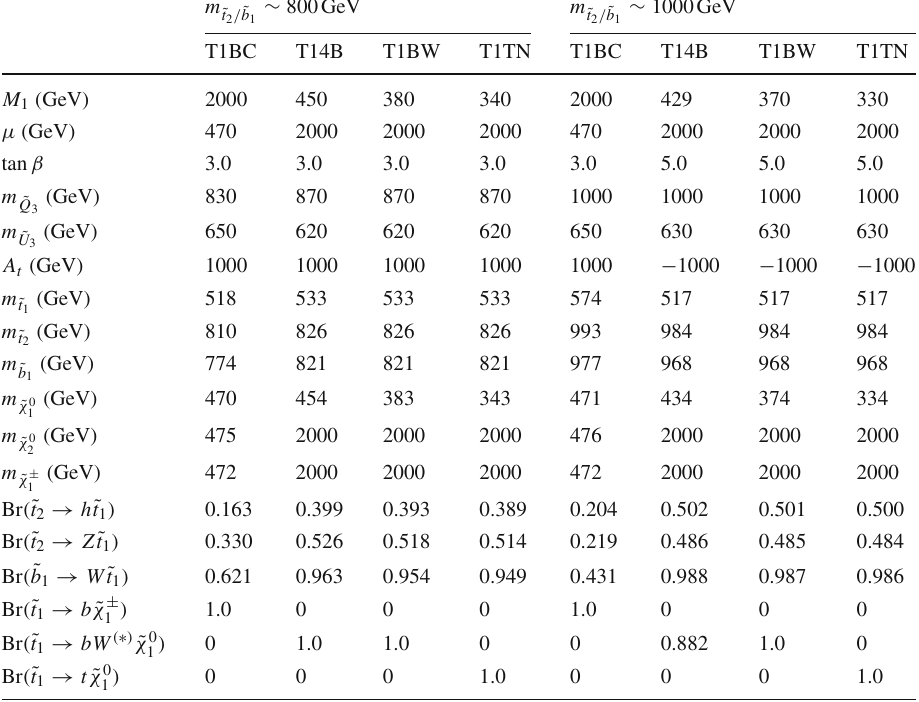
Table 1 Benchmark points for different decay modes of the right-handed dominant ˜ t 1